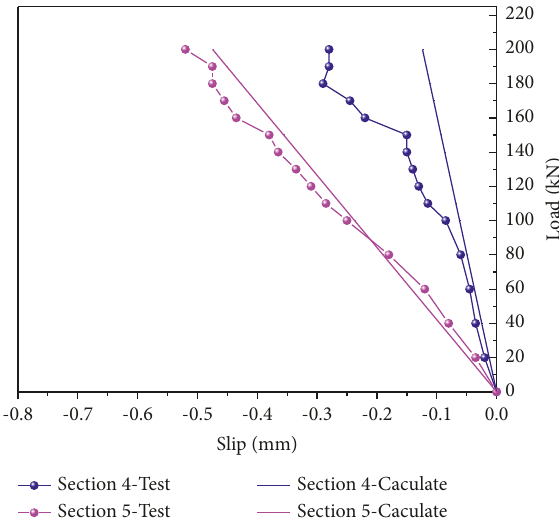
Figure 9: Interface slip of overhanging beam under